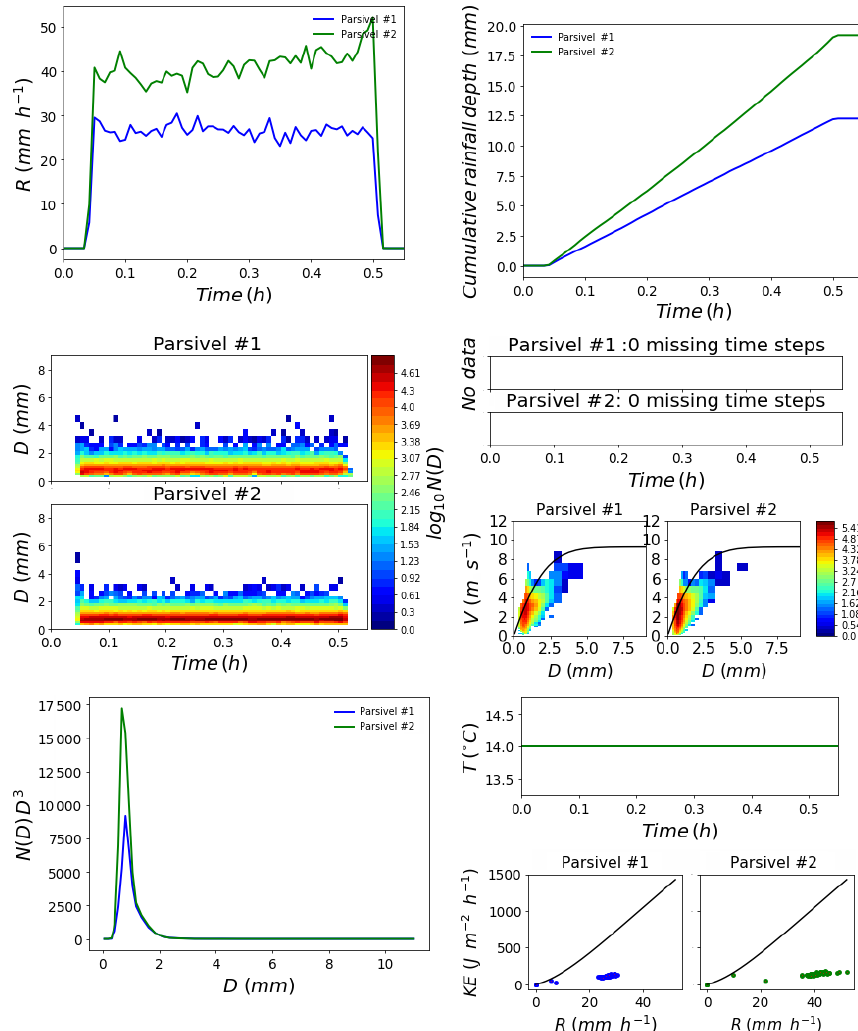
Figure 6. Quicklook of the measurements at location no. 1 with heavy rainfall.